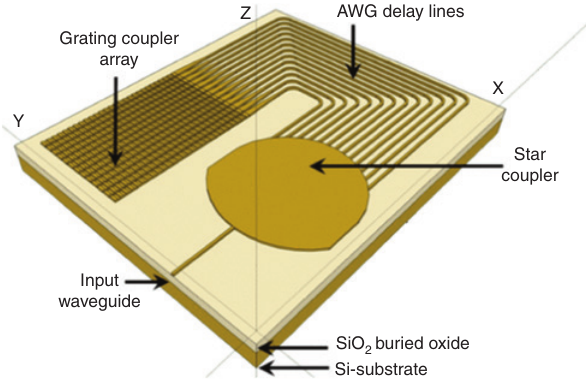
Figure 11: Schematic of a 2D beam scanner realized in a silicon photonic PIC and tunable in two dimensions by tuning the wavelength of the light at the input waveguide only [33].